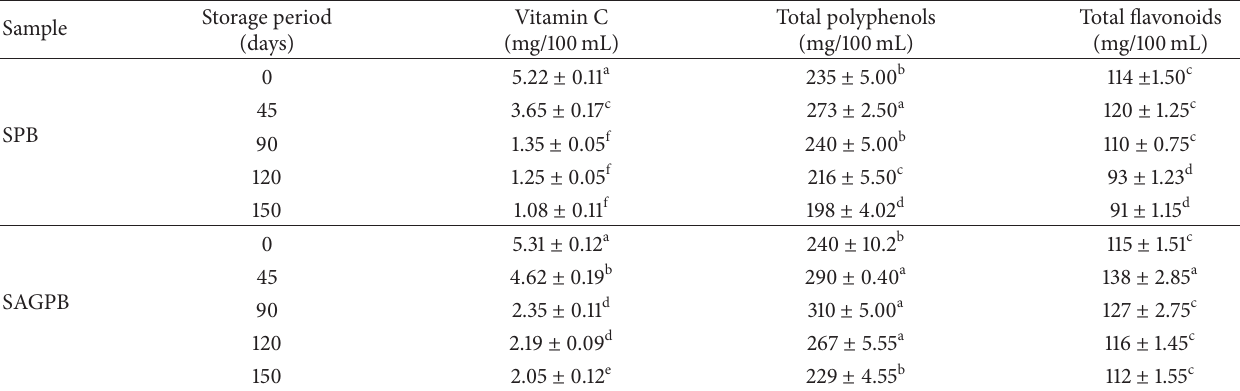
Table 3: Phytochemical content of the developed functional